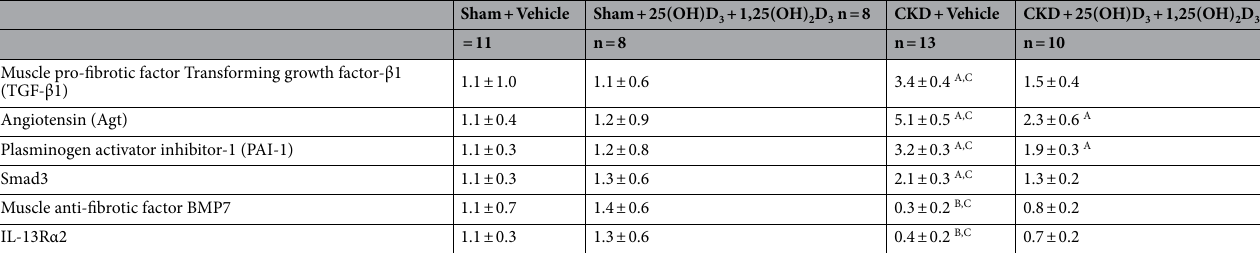
Table 3. Repletion of vitamin D modulates muscle fibrotic gene expression in CKD mice. Sham and CKD mice were treated with 25(OH)D 3 and 1,25(OH) 2 D 3 (75 μg/kg per day and 60 ng/kg per day, respectively) or ethylene glycol as vehicle for 6 weeks. Gastrocnemius muscle was used for mRNA expression study. Data are expressed and analyzed as in Table 1.